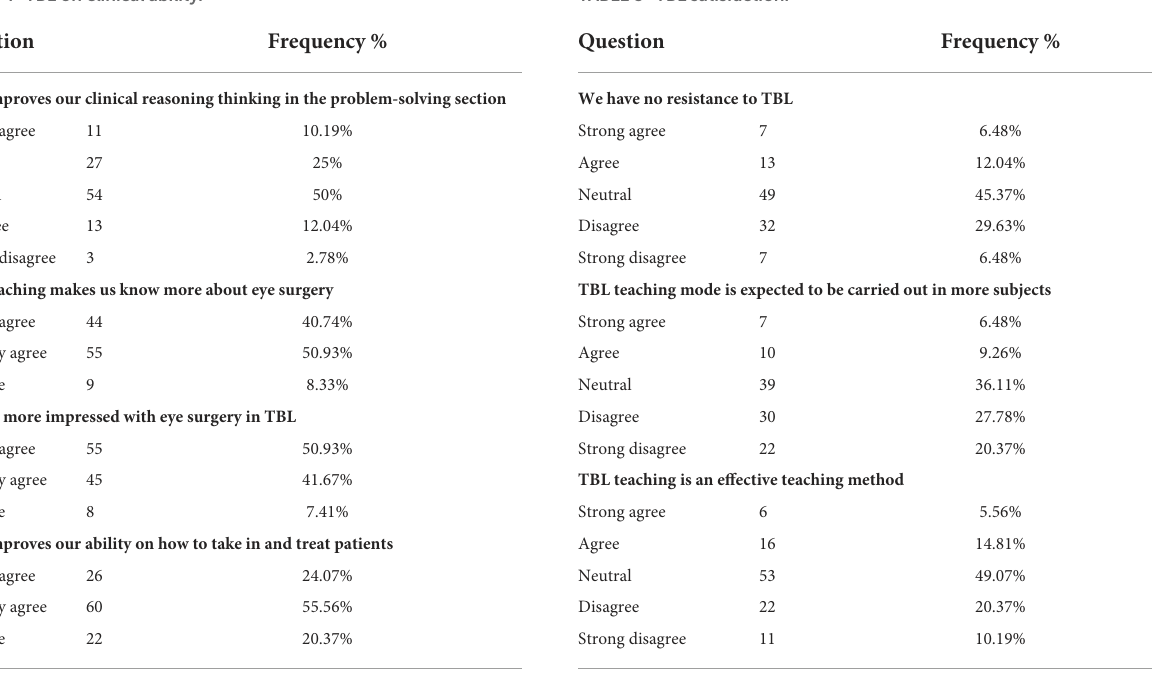
TABLE 4 TBL on clinical